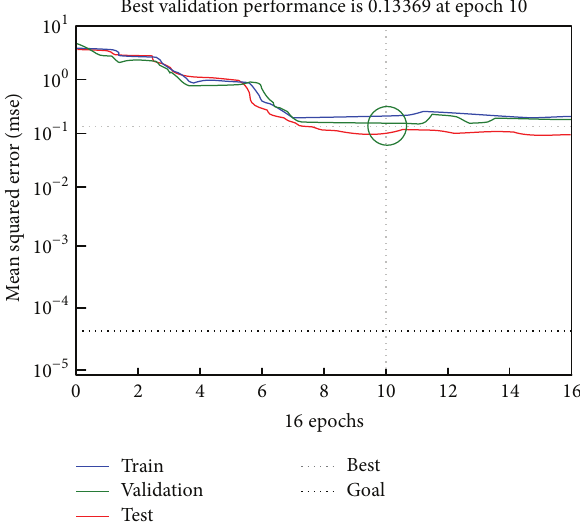
Figure 4: Training process of the Adaboost-BP neutral network